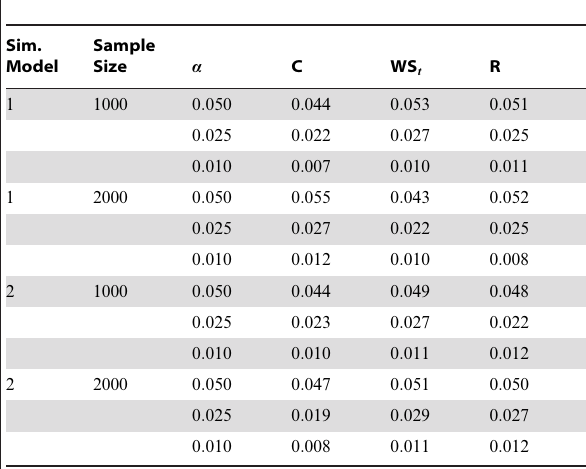
Table 2. Type-1 Error for the three approaches: collapsing (C), weighted-sum (WS t ), and replication-based